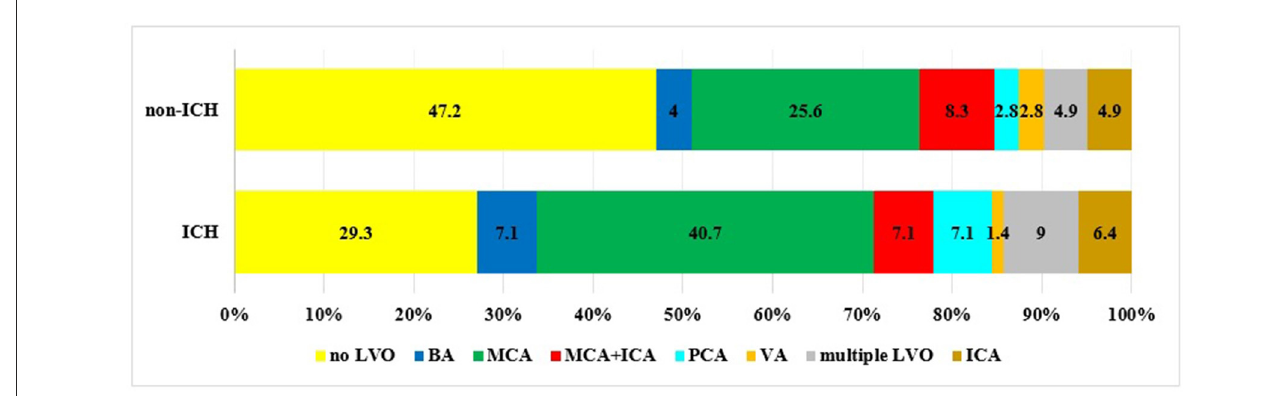
FIGURE2 Incidence of LVO in patients with ICH compared to patients without ICH (BA, basilar artery; MCA, middle cerebral artery; ICA, internal carotid artery; PCA, posterior cerebral artery; VA, vertebral